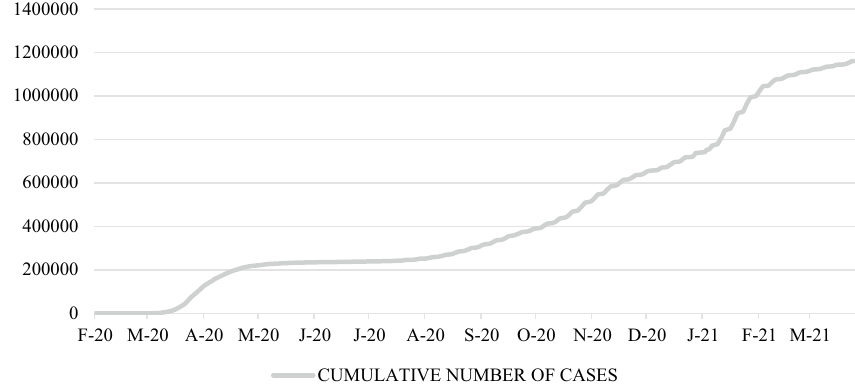
Fig. 2 Cumulative number of cases of COVID‑19 (February/2020–April/2021). Source : National Centre